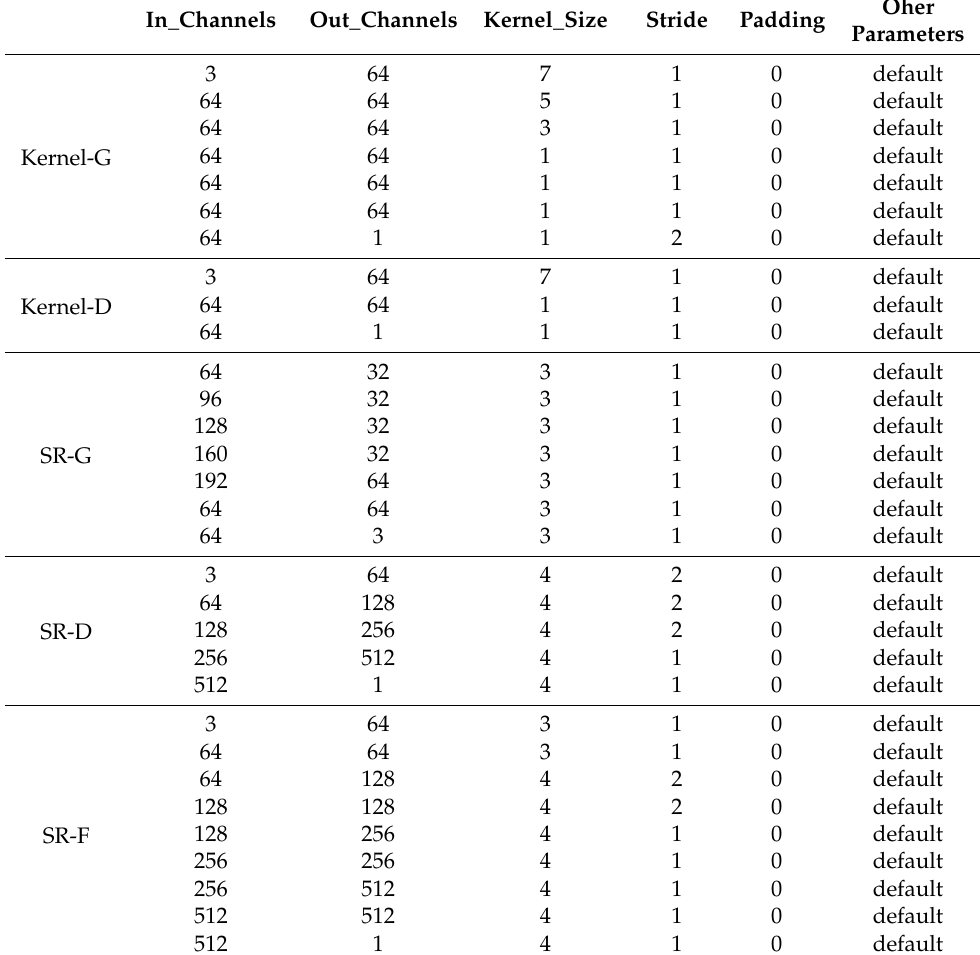
Table 1. Settings of specific parameters for convolutional layers of